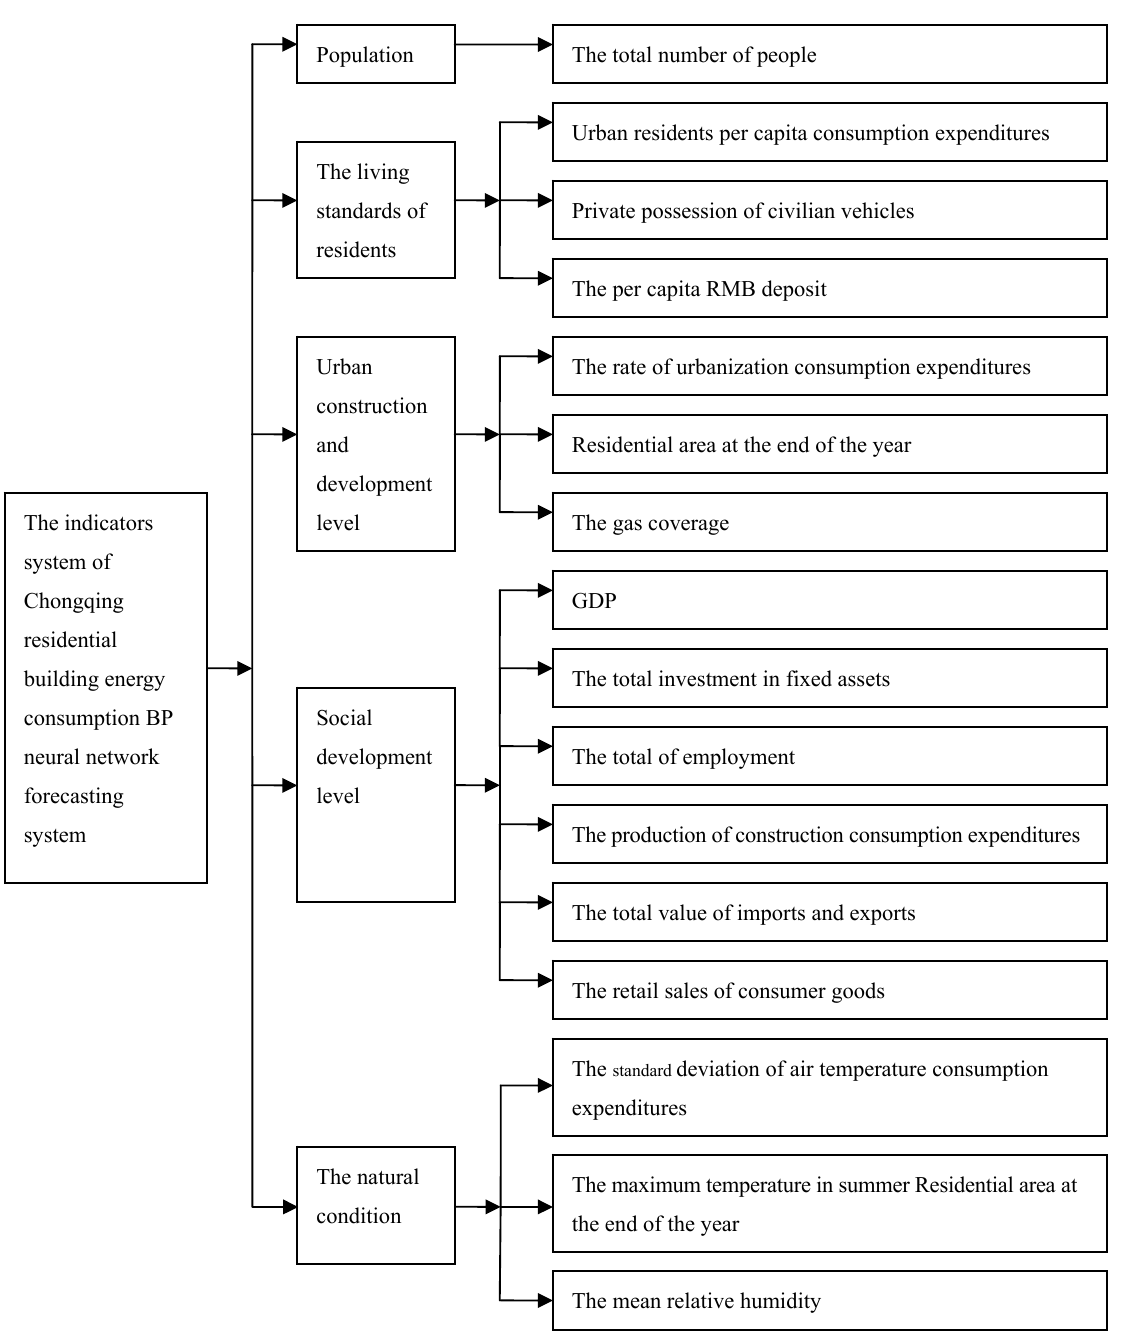
Figure 2. BP neural network forecasting model of the indicator